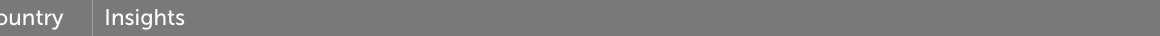
TABLE 9 Country-level insights relating to evidence gaps priorities. Country